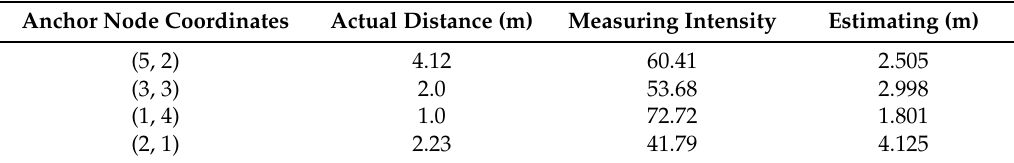
Table 9. Estimation results between node (1, 3) and anchor node.